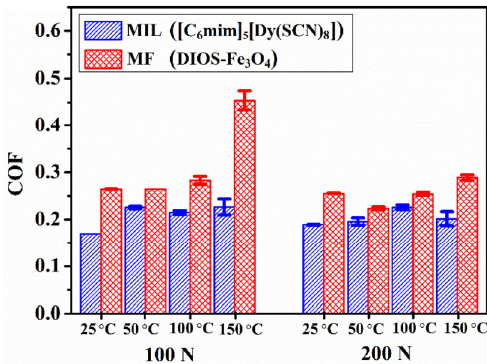
Fig. 6 Coefficients of friction of the steel-steel sliding pair lubricated by the MIL and MF at different temperatures (25, 50, 100, 150 ° C) and loads (100 and 200 N).